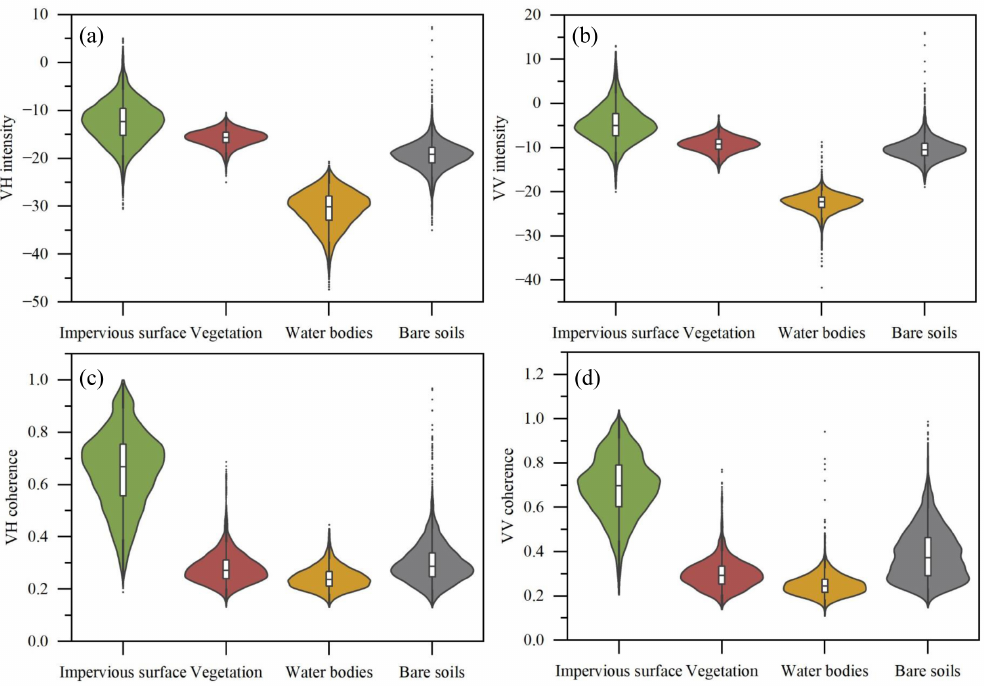
Figure 6. Differences of the intensity and coherence characteristics between impervious surfaces and other ground objects. ( a – d ) Differences between impervious surfaces and other ground objects based on VH intensity, VV intensity, VH coherence, and VV